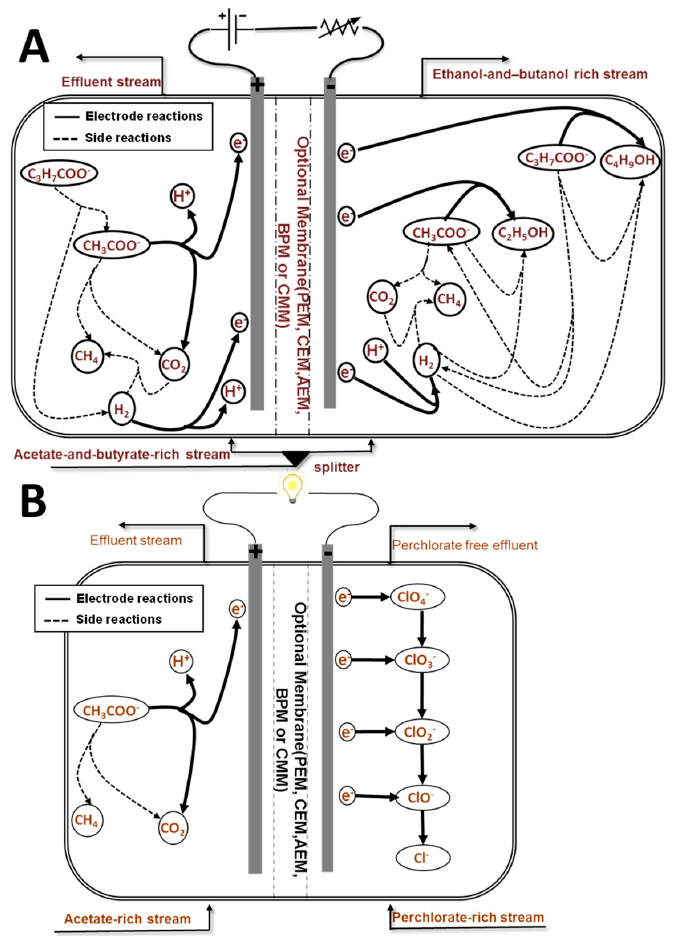
Figure 6. Proposed reactor configurations and reaction network for the ( A ) ethanol/butanol and ( B ) perchlorate reduction case studies. Details of the reactions are shown in Figures S4 and S5.